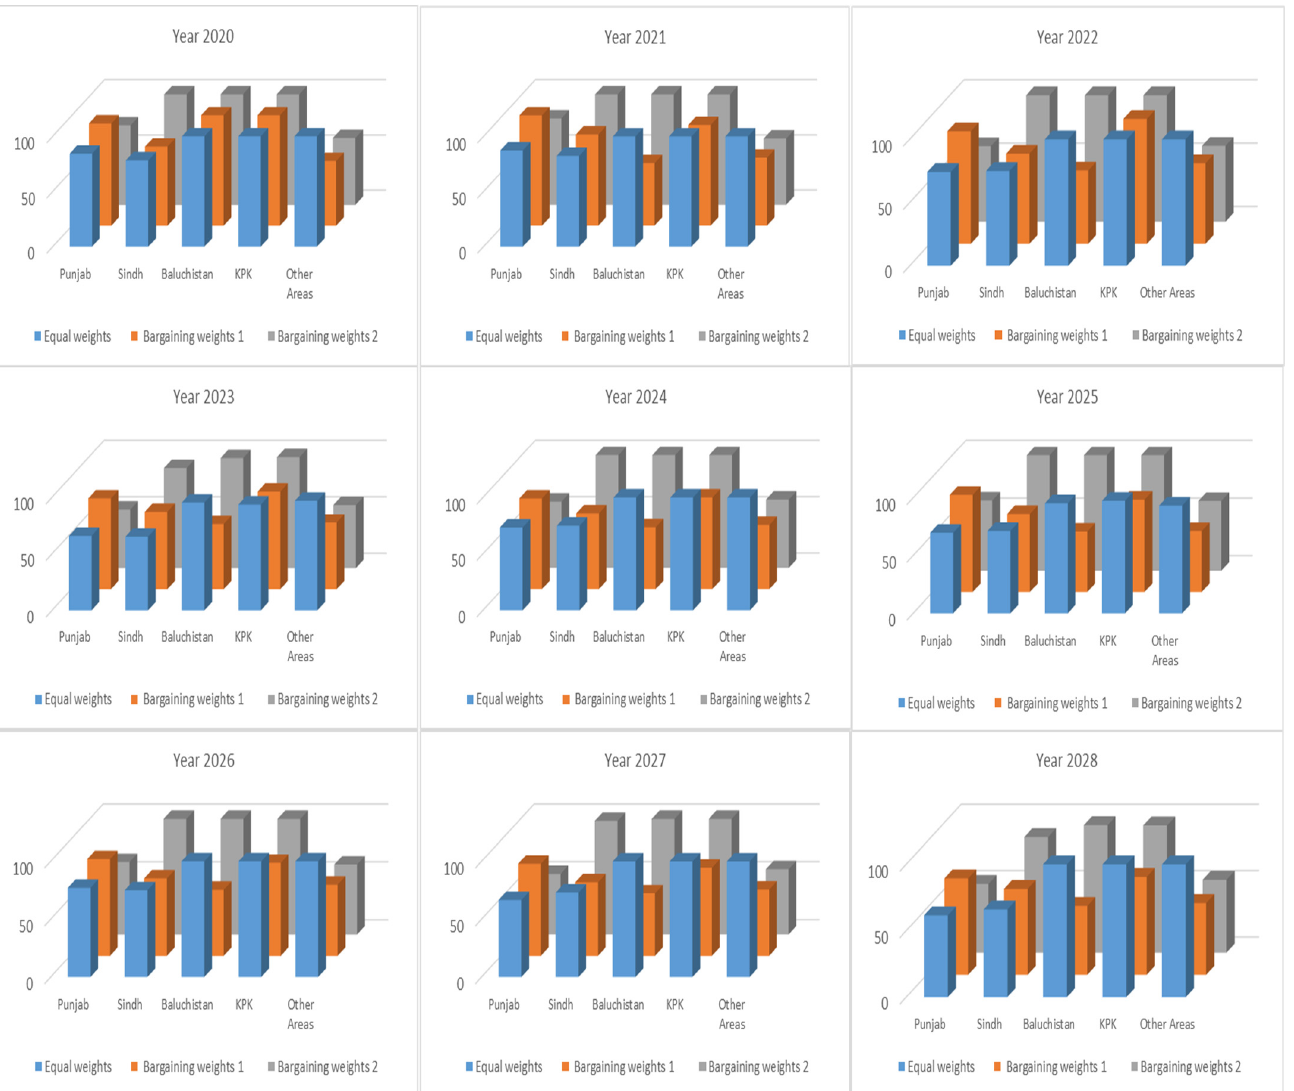
Figure 3. Gas allocation as a percentage of demand using Nash bargaining solution under equal and bargaining weights (for years 2020–2028). Table 5. ( a ) Gas allocation in BCM using equal weights for years 2020–2028. ( b ) Gas allocation in BCM using bargaining weights (Gas Production) for years 2020–2028. ( c ) Gas allocation in BCM using bargaining weights (Number of gas consumers) for years 2020–2028.